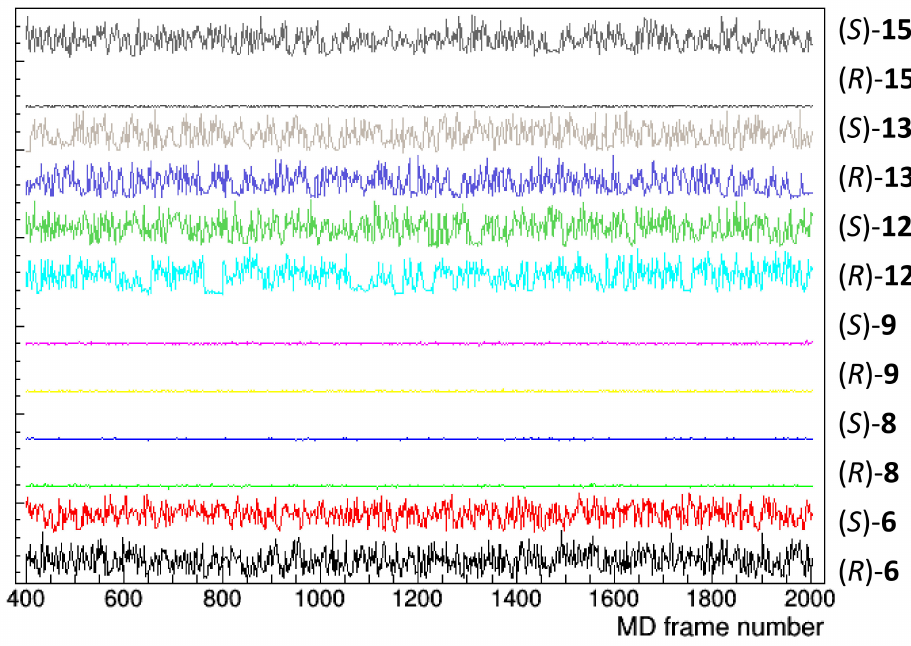
Figure 8. Distance between TAG and the compound barycentre as a function of the frame number of the MD trajectory (1 frame = 0.5 ns). Initial 400 frames, corresponding to 200 ns, have been not considered to account for system equilibration.